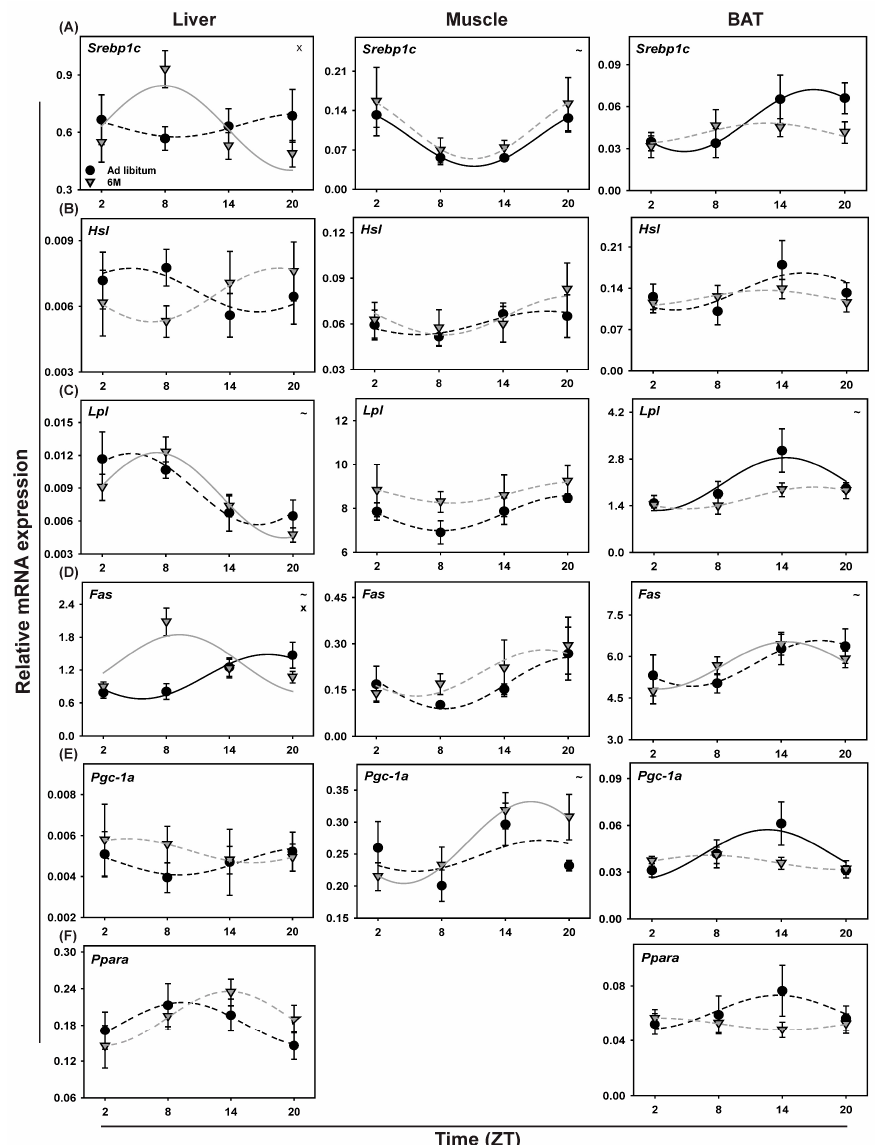
Figure 6. Daily profiles of metabolic gene expression in Liver, Muscle and BAT in animals fed ad libitum (Black circles) or according the 6 ‐ meals ‐ a ‐ day feeding schedule (Gray triangles). ( A ) Srebp1c, ( B ) Hsl, ( C ) Lpl, ( D ) Fas, ( E ) Pgc ‐ 1 α , ( F ) Ppar α , ( G ) Sirt1 and Sirt3, ( H ) Glut2 and Glut4, ( I ) Pdk4, ( J ) Fgf21 and ( K ) Ucp1 and Ucp3. Fitted lines show significant cosine regressions (see methods). ~ = effect of Time ( p <